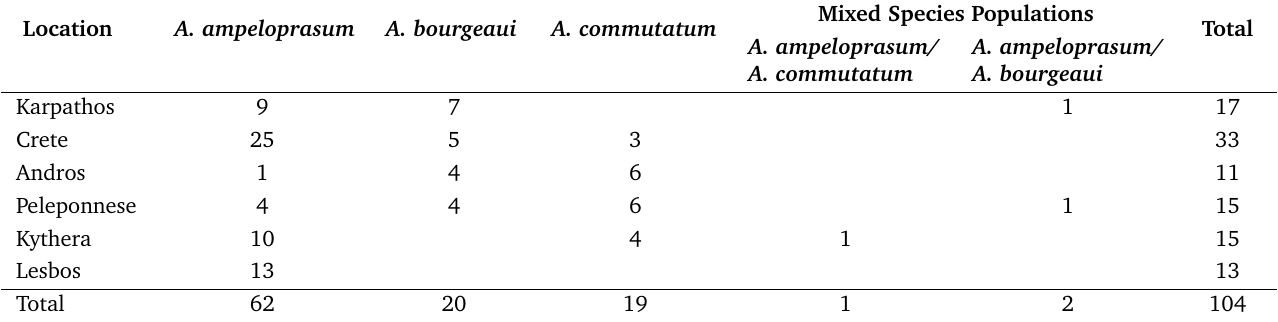
Table 1. The number of collected leek CWR populations per location visited in Greece; mixed species populations: populations in which two species are